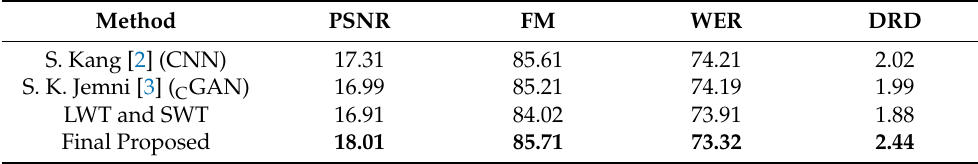
Table 3. Comparative results on S-MS [27] dataset.